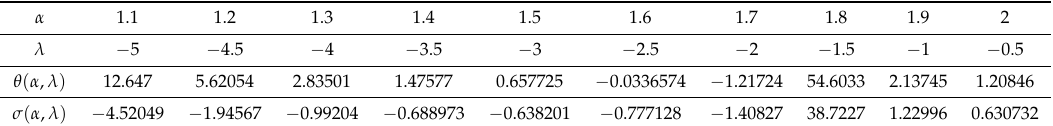
Table 1. Somevalues of θ and σ for 1 < α ≤